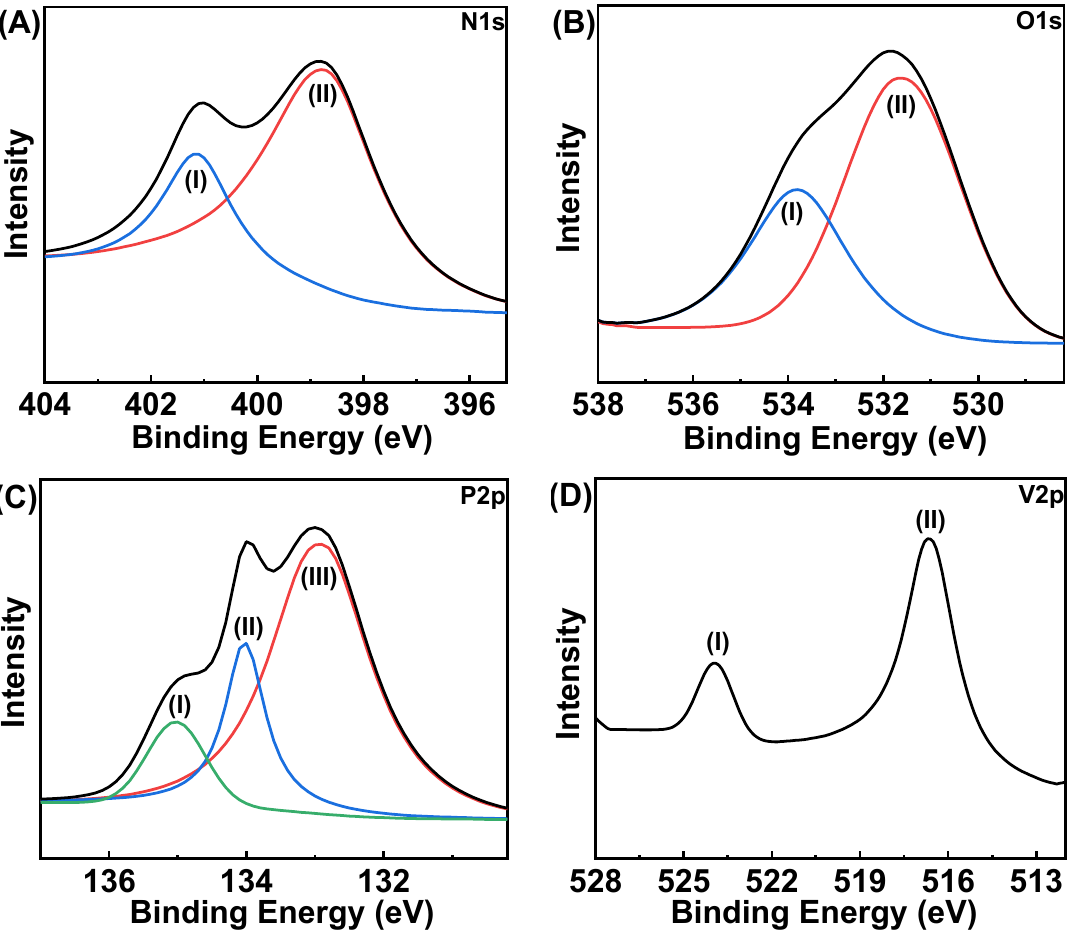
Figure 2. Curve-fitted XPS high-resolution spectra of HCCP-V: ( A ) N1s, ( B ) O1s, ( C ) P2p, and ( D ) V2p.